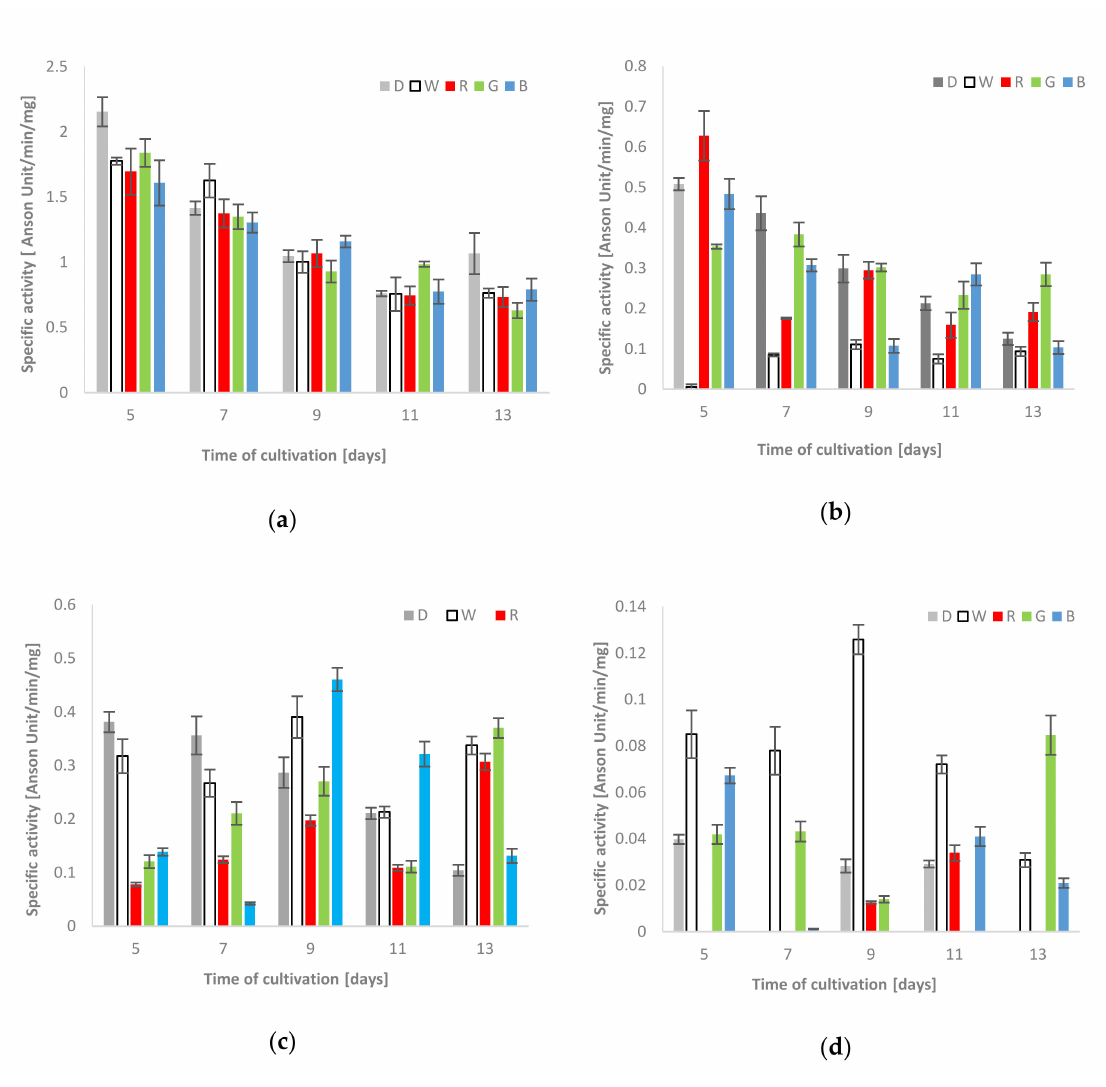
Figure 2. Total activities of acid [( a )–extra-and ( b )–intracellular] and alkaline proteases [( c )–extra-and( d )–intracellular] using hemoglobin as a reaction substrate detected during C. unicolor growth in the dark (D), white (W), red (R), green (G) and blue light (B)